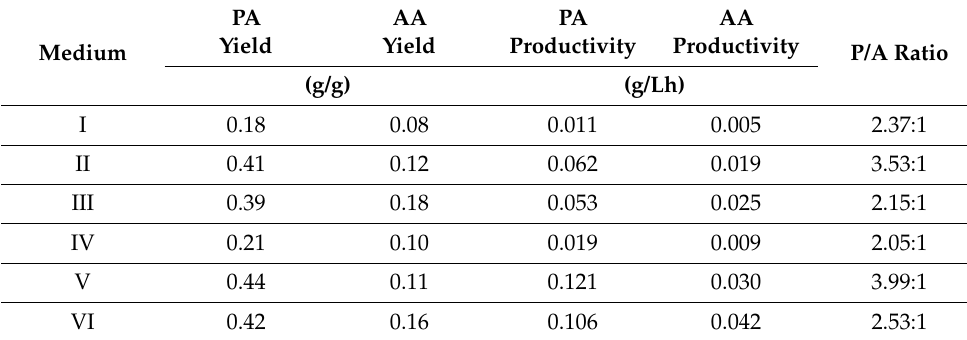
Table 2. Parameters of propionic acid